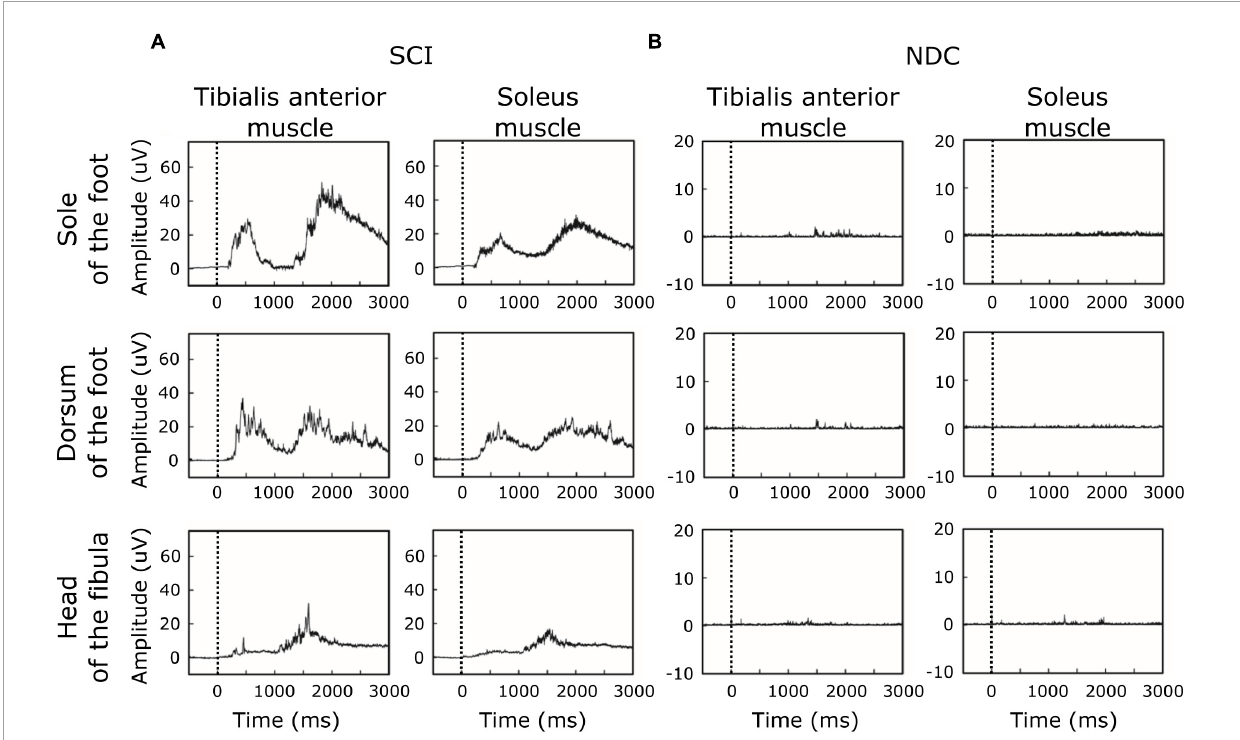
FIGURE2 Grand averages of motor responses. (A) In participants with spinal cord injury (SCI), averaged EMG-responses to laser stimuli revealed two main time-windows of reflex activity (early ∼ 250 ms and late > 1,000 ms), suggesting involvement of both A-delta-fibers and C-fibers. In SCI, reflex activity was associated with co-activation of antagonistic muscles (tibialis anterior and soleus muscle). (B) In contrast, non-disabled controls (NDC) were characterized by generally less marked muscle responses, only detectable in the late time-window ( > 1,000 ms) and without co-activation of the soleus muscle. The black dashed line indicates the onset of the stimulus.